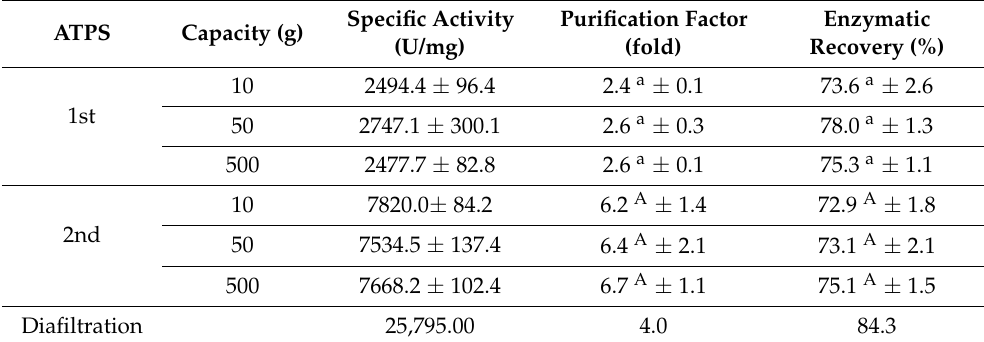
Table 1. Purification factor (PF) and enzymatic recovery (REC) for Bacillus sp. P45 protease purified by integrated strategy in large volume systems. The statistical analysis was conducted by ANOVA followed the Tukey’s test. Equal lowercase (1st ATPS) or uppercase letters (2nd ATPS) in the same column indicate no statistical difference at the 5% level for the purification factor and enzymatic recovery for each of the two-phase aqueous systems studied. Specific Activity Purification Factor Enzymatic ATPS Capacity (g) (U/mg) (fold) Recovery